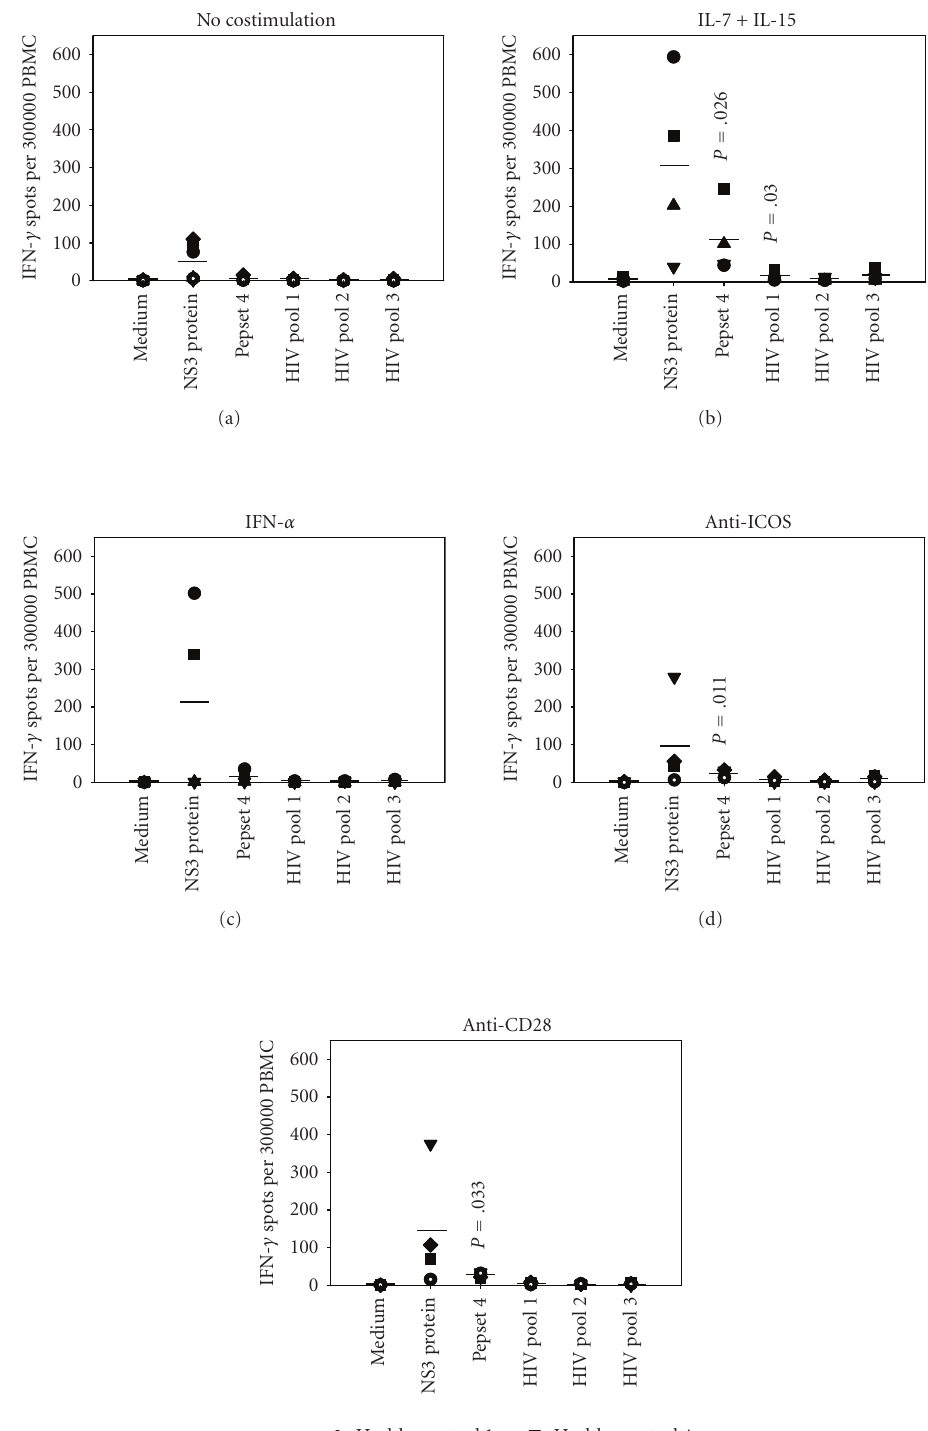
Figure 3: In vitro costimulation causes false-positive T cell responses to HCV and HIV antigens in healthy individuals. PBMCs of 6 healthy individuals were tested in IFN- γ ELISPOT assays for their recall responses to NS3 protein, Pepset 4 peptide pool, and HIV peptide pools 1, 2, and 3 in the absence (a) or presence of IL-7/IL-15 (b), IFN- α (c), anti-ICOS (d), or CD28 (e). For each individual, the mean spot count of duplicate wells is shown. Horizontal bars indicate the means of all individual responses to the respective antigens. P values are given for means that are significantly di ff erent from baseline values in (a). Symbols in (a) also apply to